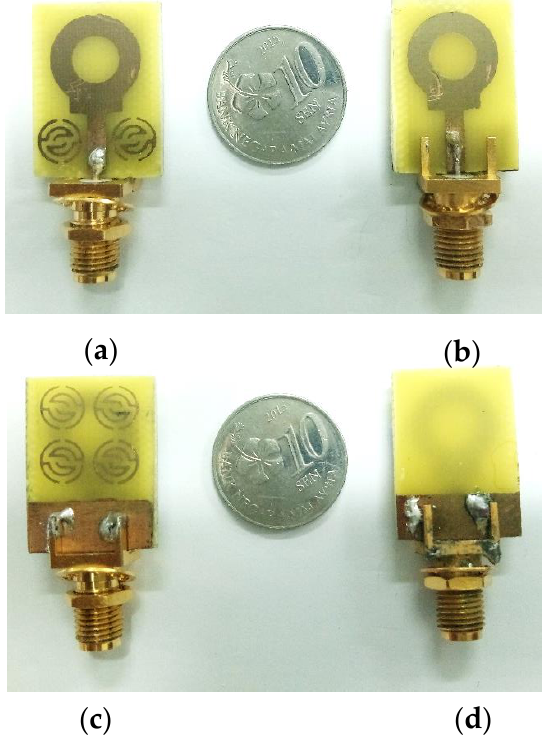
Figure 13. Fabricated prototypes of the proposed antennas, front view: ( a ) with MTM and ( b ) without MTM; back view: ( c ) with MTM and ( d ) without MTM.